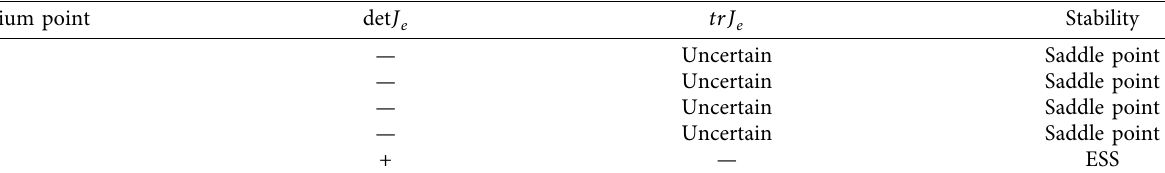
Table 6: Partial equilibrium analysis.